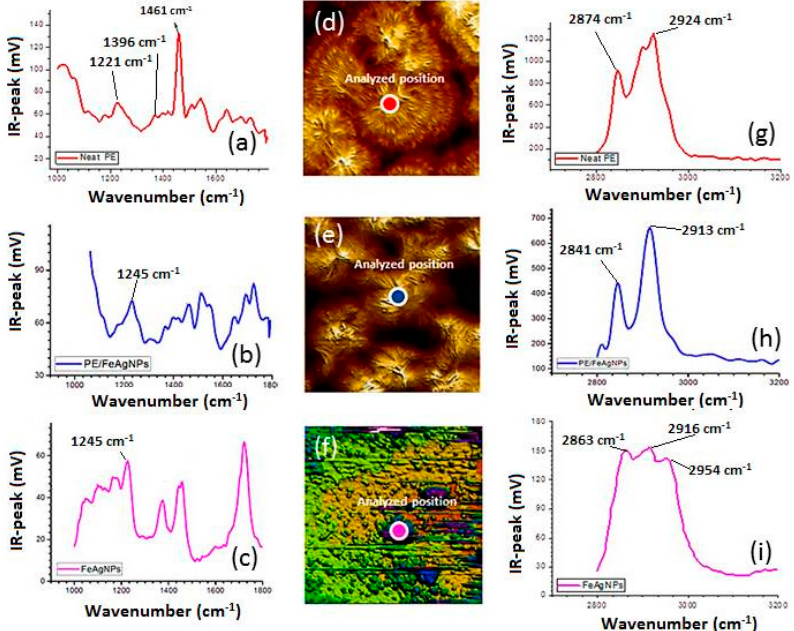
Figure 5. Nano-IR spectra at the region 1000–1800 cm − 1 ( a ) neat HDPE, ( b ) HDPE/FeAg